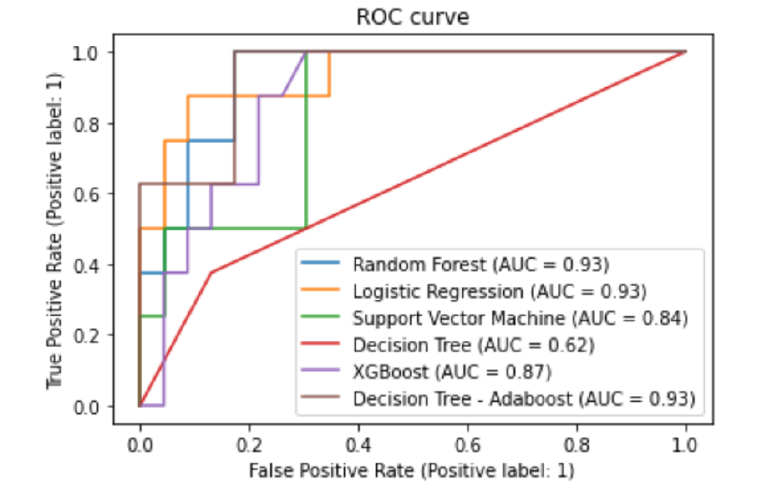
Figure 1. ROC for different machine learning models.